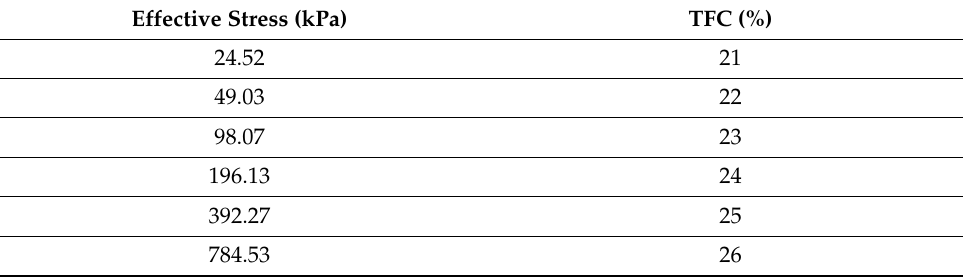
Table 2. Transition fines content under different vertical effective